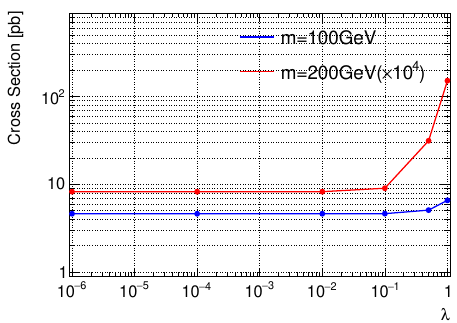
¯ Figure 1 . Fiducial cross section of Pb + Pb → Pb + Pb + e + e − d d driven by the leptoquark S 3 in ultra- √ peripheral collisions at s = 5 . 03 TeV as a function of the coupling constant λ ed with a mass of 100 GeV (blue curve) or 200 GeV (red curve, scaled by a factor of 10 4